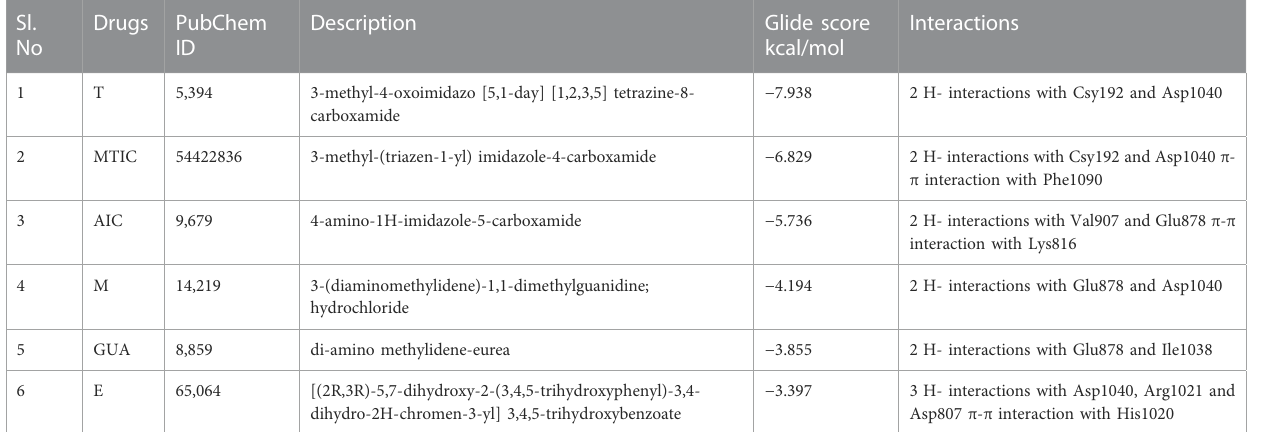
TABLE 2 Interaction pro fi les of the experimental compounds with 3HNG. Sl. No